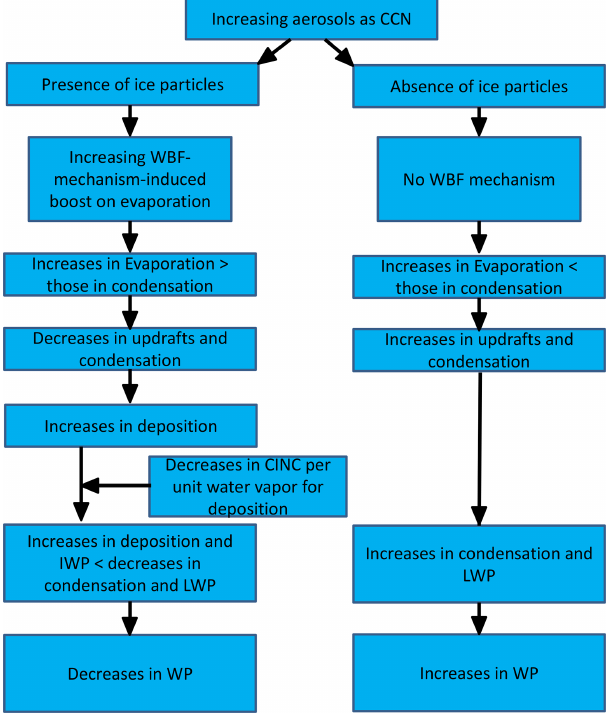
Figure 13. A schematic diagram that depicts the flow of processes that are described in Sect. 4.2.1 and associated with responses of clouds to increasing aerosols acting as